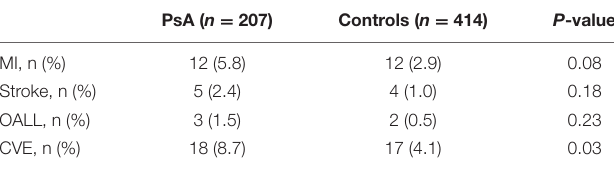
TABLE 2 | Prevalence of cardiovascular events in patients with PsA and controls. TABLE 4 | Cardiovascular risk according to QRISK2 and QRISK2-PsA equations.